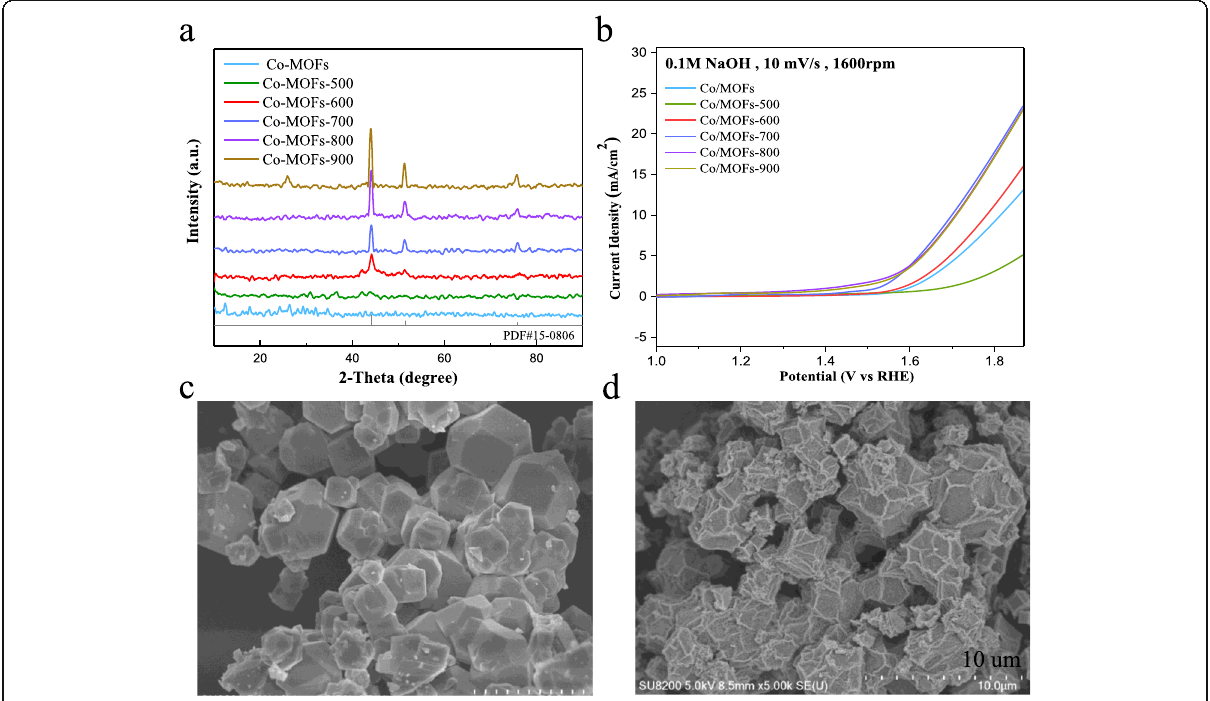
Fig. 1 a XRD patterns of Co/MOF samples before carbonized and carbonized at different temperatures. b LSV curves for the OER of Co/MOFs, Co/MOFs-500, Co/MOFs-600, Co/MOFs-700, Co/MOFs-800, and Co/MOFs-900. c , d SEM images of Co/MOFs-700 sample before and after